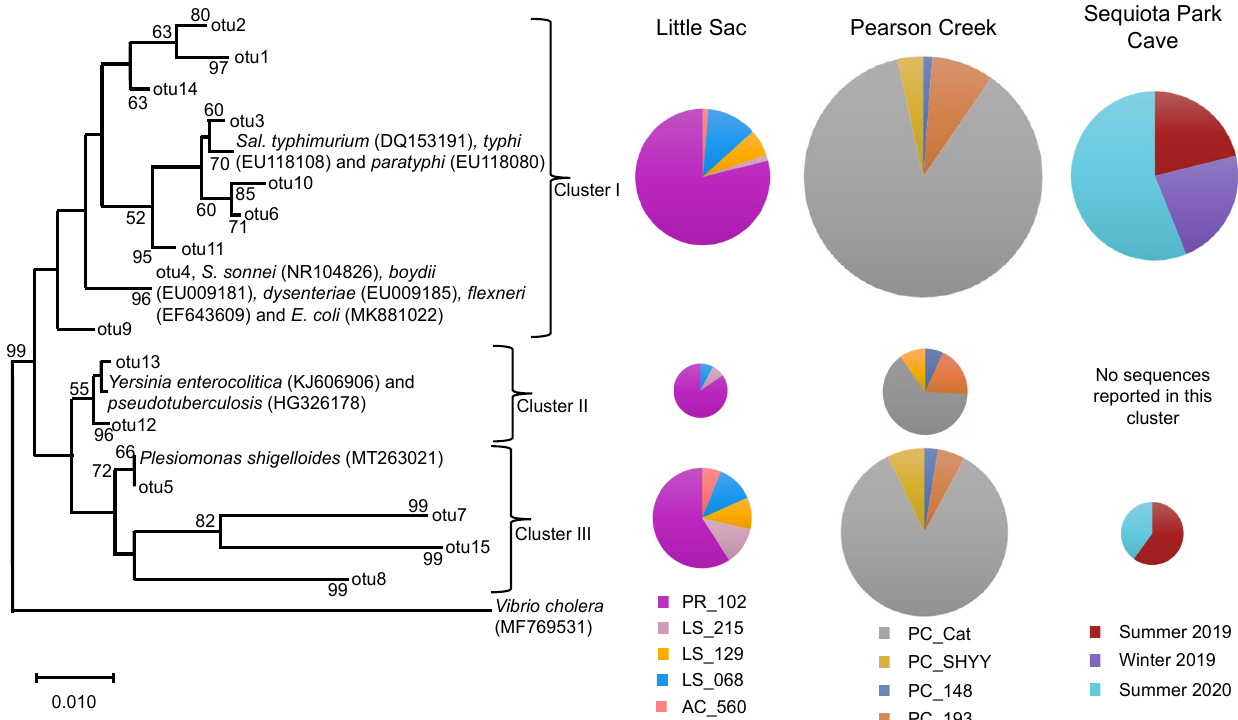
Figure 3. Neighbor-joining phylogenetic tree of partial 16S rRNA gene sequences (370 bp) related to the Enterobacteriaceae family from three impaired watersheds. Only OTUs containing ≥ 50 sequences were used in this analysis. The DNA sequences of some related pathogenic species within the Enterobacteriaceae family were also included in the analysis. The size of the pie chart is proportional to the number of sequences within a cluster. The size of a pie chart can only demonstrate the variation in sequences within a given watershed, e.g., a pie chart from the LSW site cannot be compared with pie charts from Pearson creek. Numbers at the node reflect the bootstrap values.